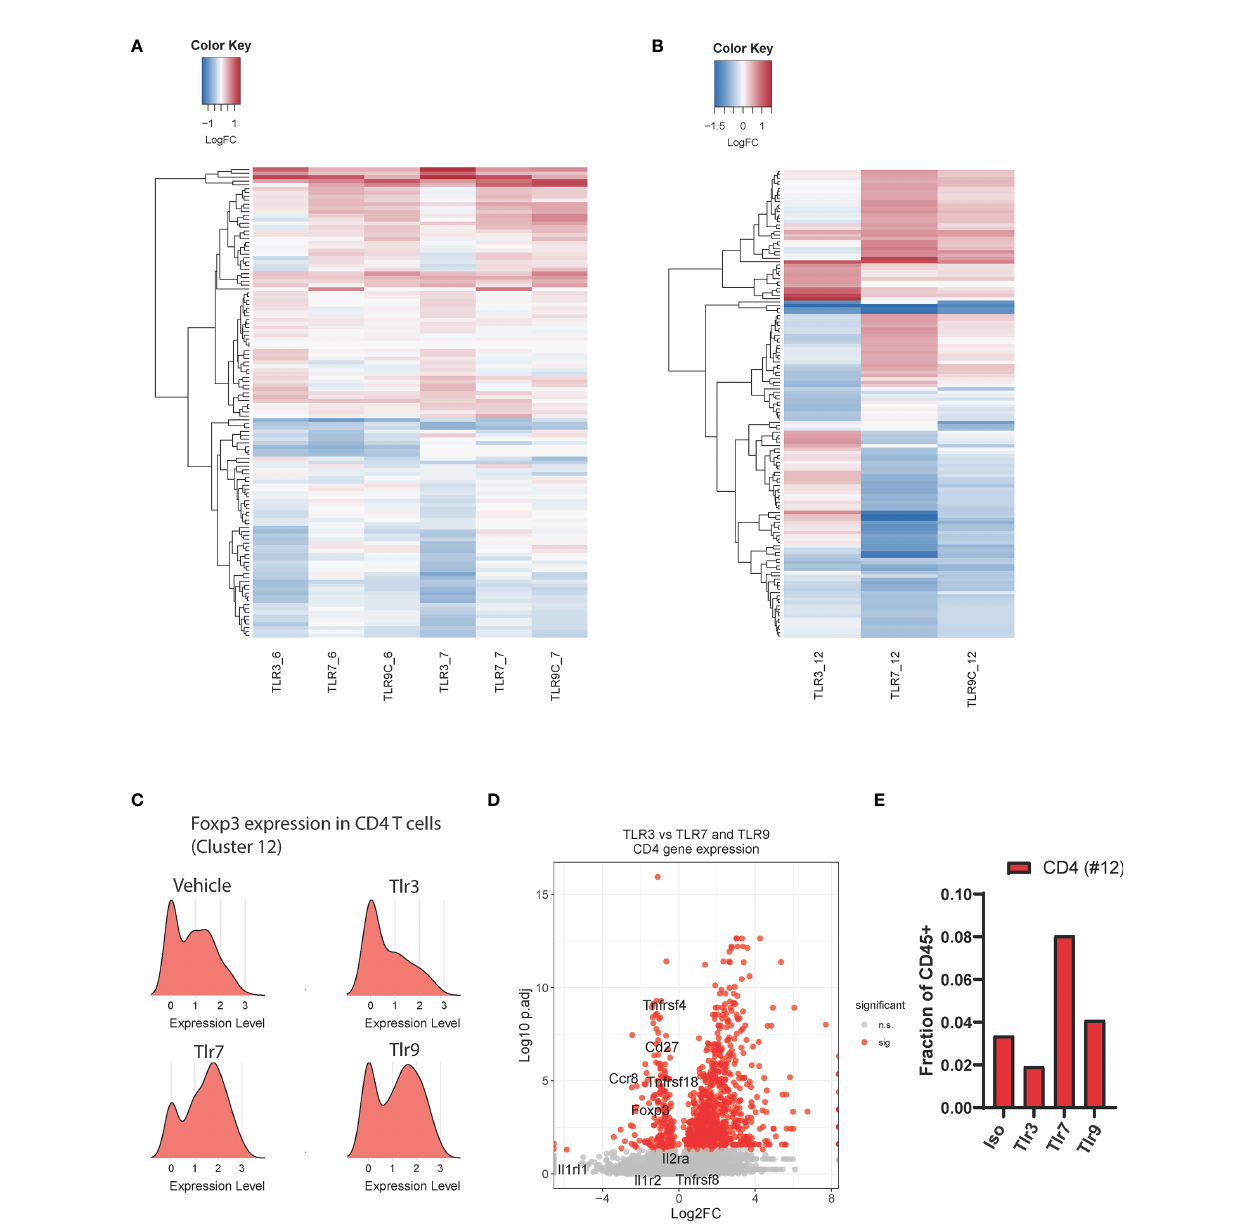
FIGURE 4 | Effects of TLR treatment on adaptive immune cell populations. Hierarchical clustering of differential expressed genes between treatment conditions for, (A) CD8 T cell subsets 6 (activated, non-proliferative) and 7 (activated, proliferative), and (B) CD4 T cell subset 12. (C) Ridge plot showing Foxp3 mRNA expression in CD4 T cell cluster 12 upon TLR agonist treatment, (D) The relative expression of Treg-associated genes in CD4 T cells (cluster 12) from TLR3-treated samples compared to the average expression of these genes in the same cluster for TLR7 and TLR9-treated samples, and (E) the total frequency of tumor-in fi ltrating CD4 T cells as a percentage of CD45+ cells upon treatment with TLR